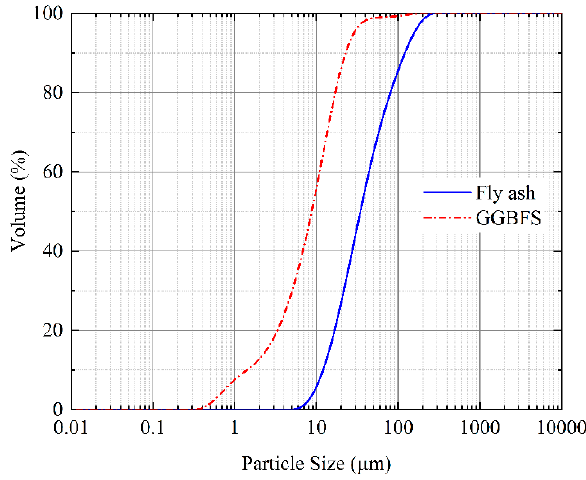
Table 1. Chemical components of fly ash (FA) and ground granulated blast furnace slag (GGBFS) by X-ray fluorescence (XRF) analysis.